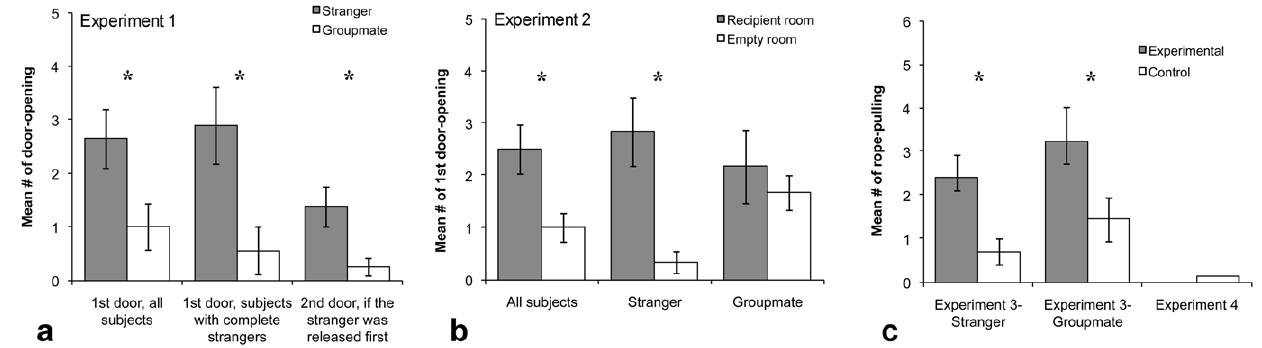
Figure 2. Results of experiment 1–4. ** p # 0.10, * p # 0.05, Wilcoxon test. In experiment 1 ( a ), we used two-tailed statistics. Based on the directional results of experiment 1 and those of [12], we had a priori predictions bonobos are spontaneously and preferentially prosocial toward strangers. Therefore, in experiment 2 ( b ) and 3–4 ( c ) we were justified to use one-tailed statistics.